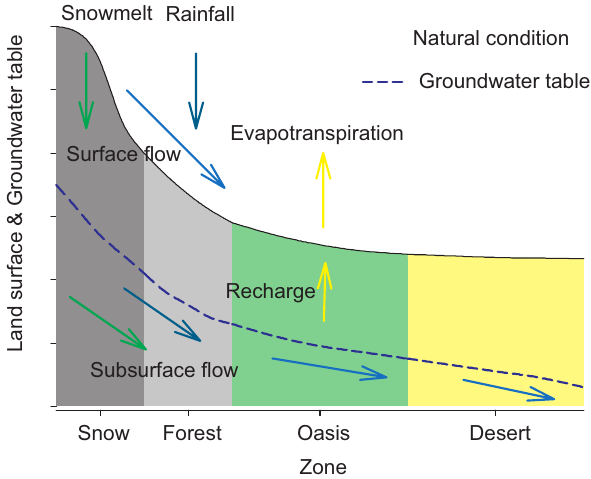
Figure 9. Groundwater dynamics in the natural stage (typical qual- itative patterns in this